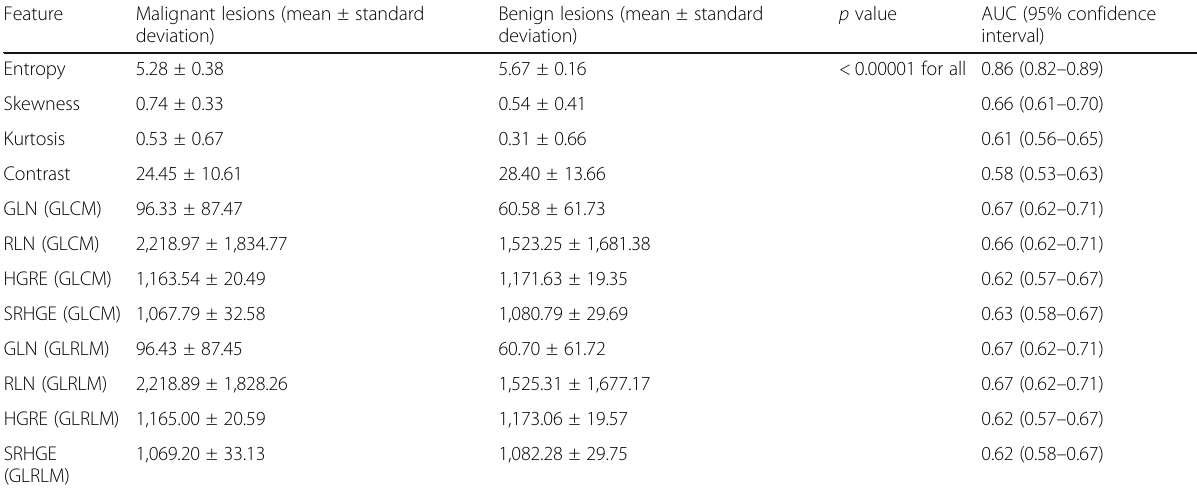
Table 3 Texture features that showed significantly different mean values comparing malignant versus benign solid lesions and corresponding area under the curve (AUC)